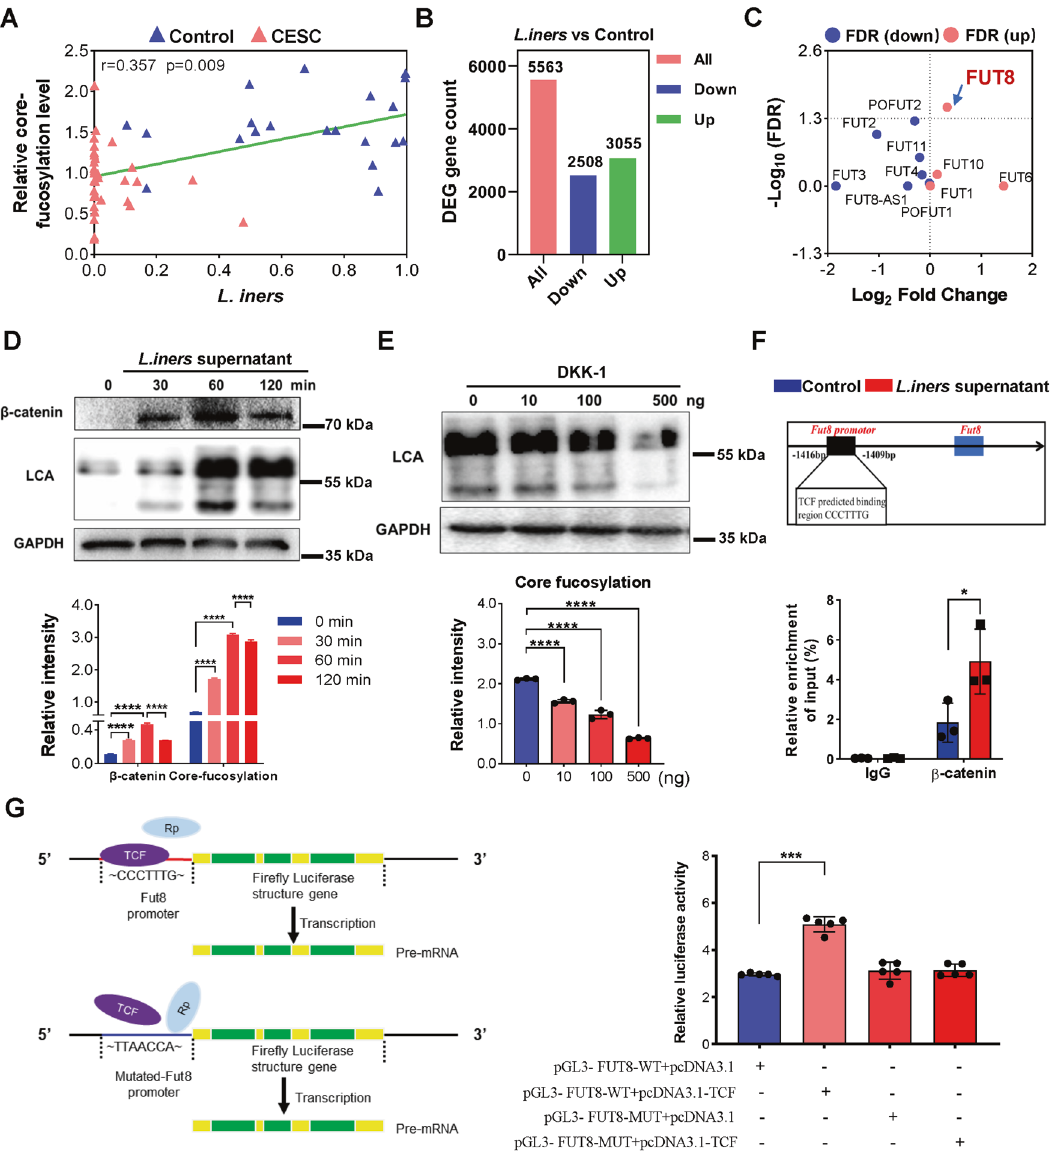
Fig. 5 L. iners metabolites increased the core fucosylation of epidermal cells by activating the Wnt pathway. A Correlation analysis between the relative abundance of L. iners and core protein fucosylation. B Histogram of differentially expressed genes in SiHa cells stimulated with L. iners metabolites. C L. iners metabolites stimulated the expression of glycosylation-related genes in SiHa cells. D The level of core fucosylation and expression of β -catenin after treatment with L. iners metabolites. E After SiHa cells were treated with L. iners metabolites, DKK- 1 at different doses was added, and the core fucosylation of epidermal cells was measured. F ChIP-qPCR was used to verify the binding of TCF/ β -catenin to the promoter of the Fut8 gene. G Dual-luciferase reporter gene assay to verify the regulatory effect of TCF to the promoter of the Fut8 gene. * p < 0.05, *** p < 0.001, **** p <